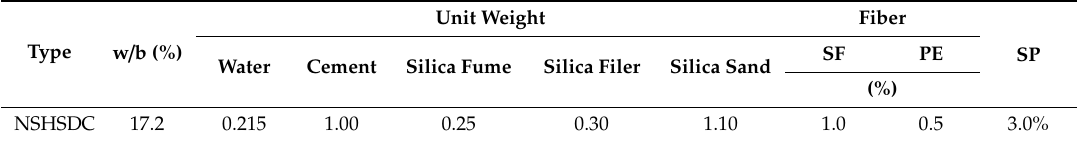
Table 3. Mix proportions of no-slump high-strength, high-ductility concrete (NSHSDC; by cement weight ratio).